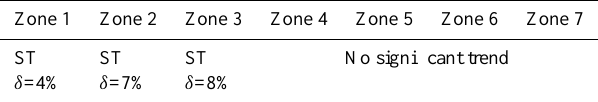
Table 1. Result of the regional multivariate test for trend detection in the ADM rainfall, ST indicates a significant trend at the 10% risk level, and δ is the trend